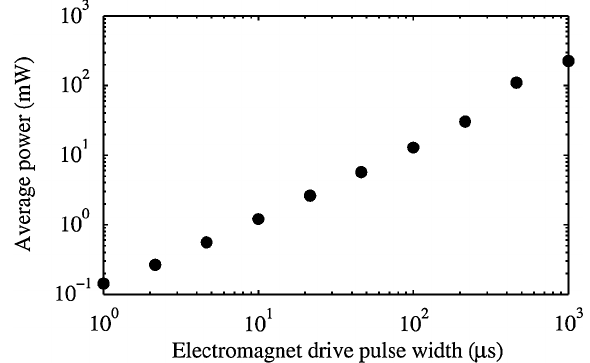
FIG. 8. Average power dissipation calculated for a short duty cycle (0.1% – 96%) 1 A pulse train at 960 Hz using complex impedance measurements from the prototype quadrupole.